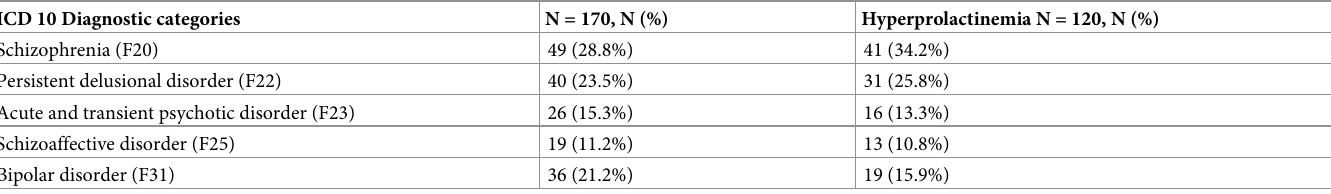
Table 2. Diagnostic subcategories and hyperprolactinemia.